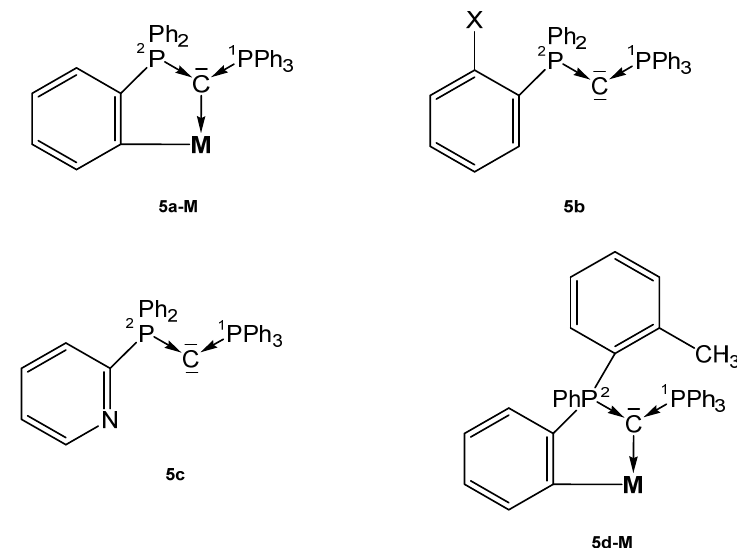
Figure 7. Structures of compounds 5a-M , 5b , 5c and 5d-M .